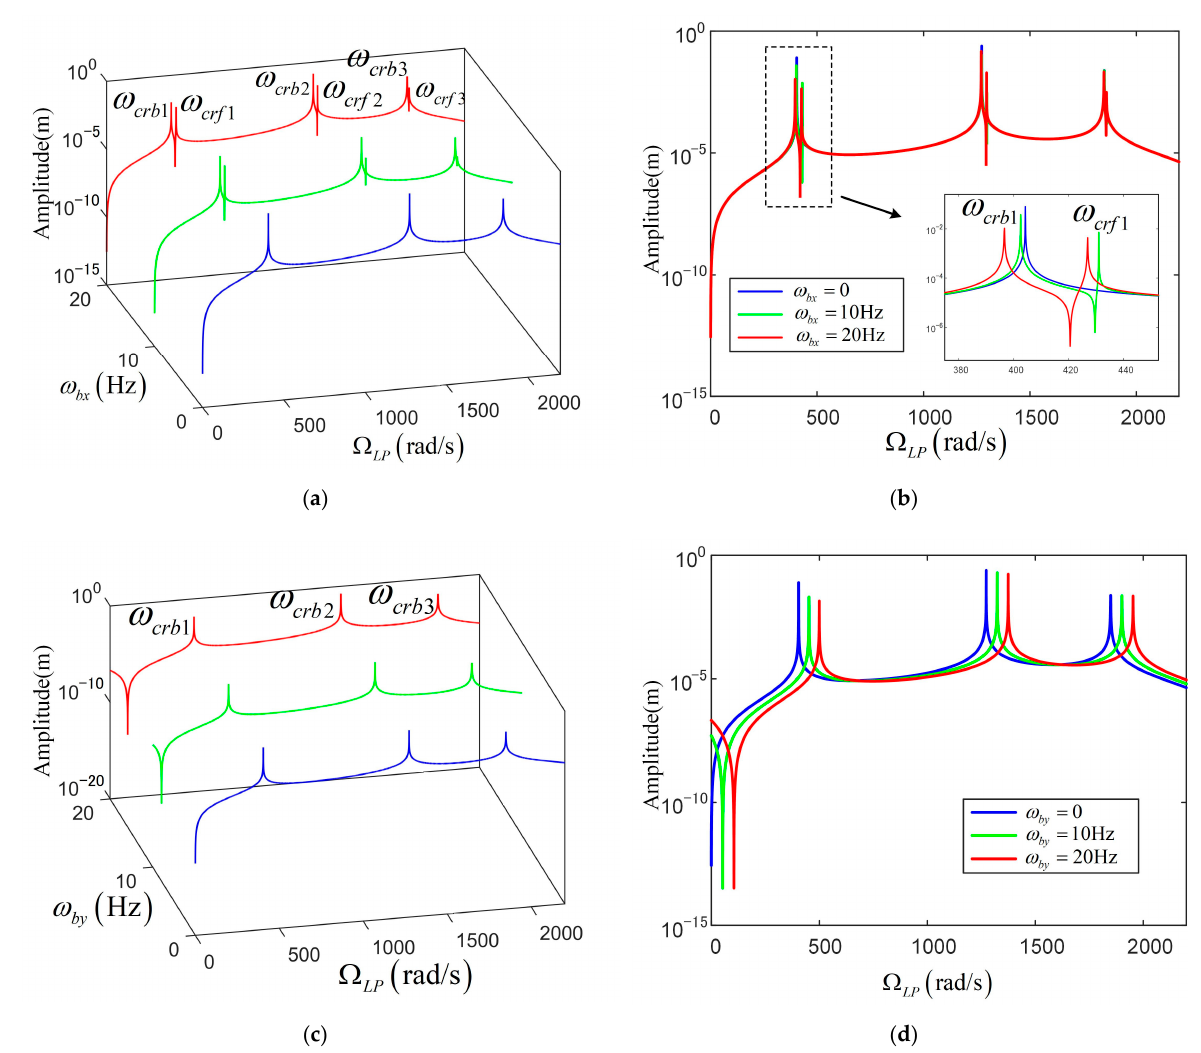
Figure 7. Responses of the dual-rotor system excited by mass unbalance on disk 3 with base motions: ( a ) Pitching base motion; ( b ) Pitching base motion; ( c ) Rolling base motion; ( d ) Rolling base motion.